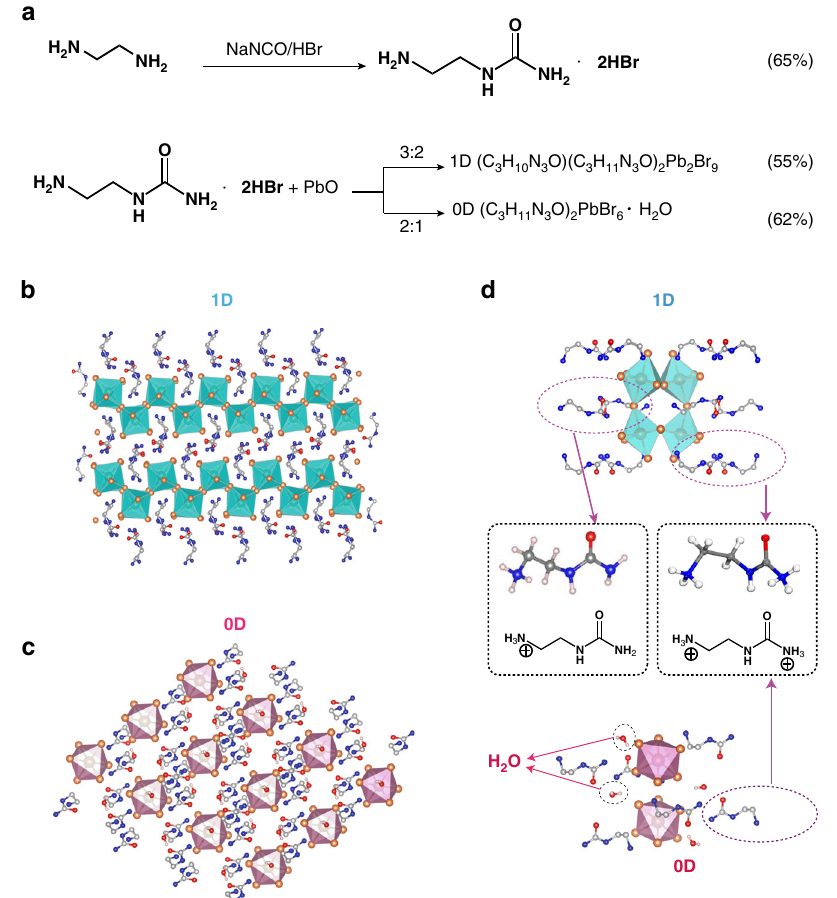
Fig. 1 The synthesis and structural characterization of crystals of 1D and 0D lead bromide hybrids. a Schemes for the synthesis of urea-amide hydrobromide and 1D, 0D lead bromide perovskite single crystals; Crystal structures of b 1D (C 3 N 3 H 10 O)(C 3 N 3 H 11 O) 2 Pb 2 Br 9 and c 0D